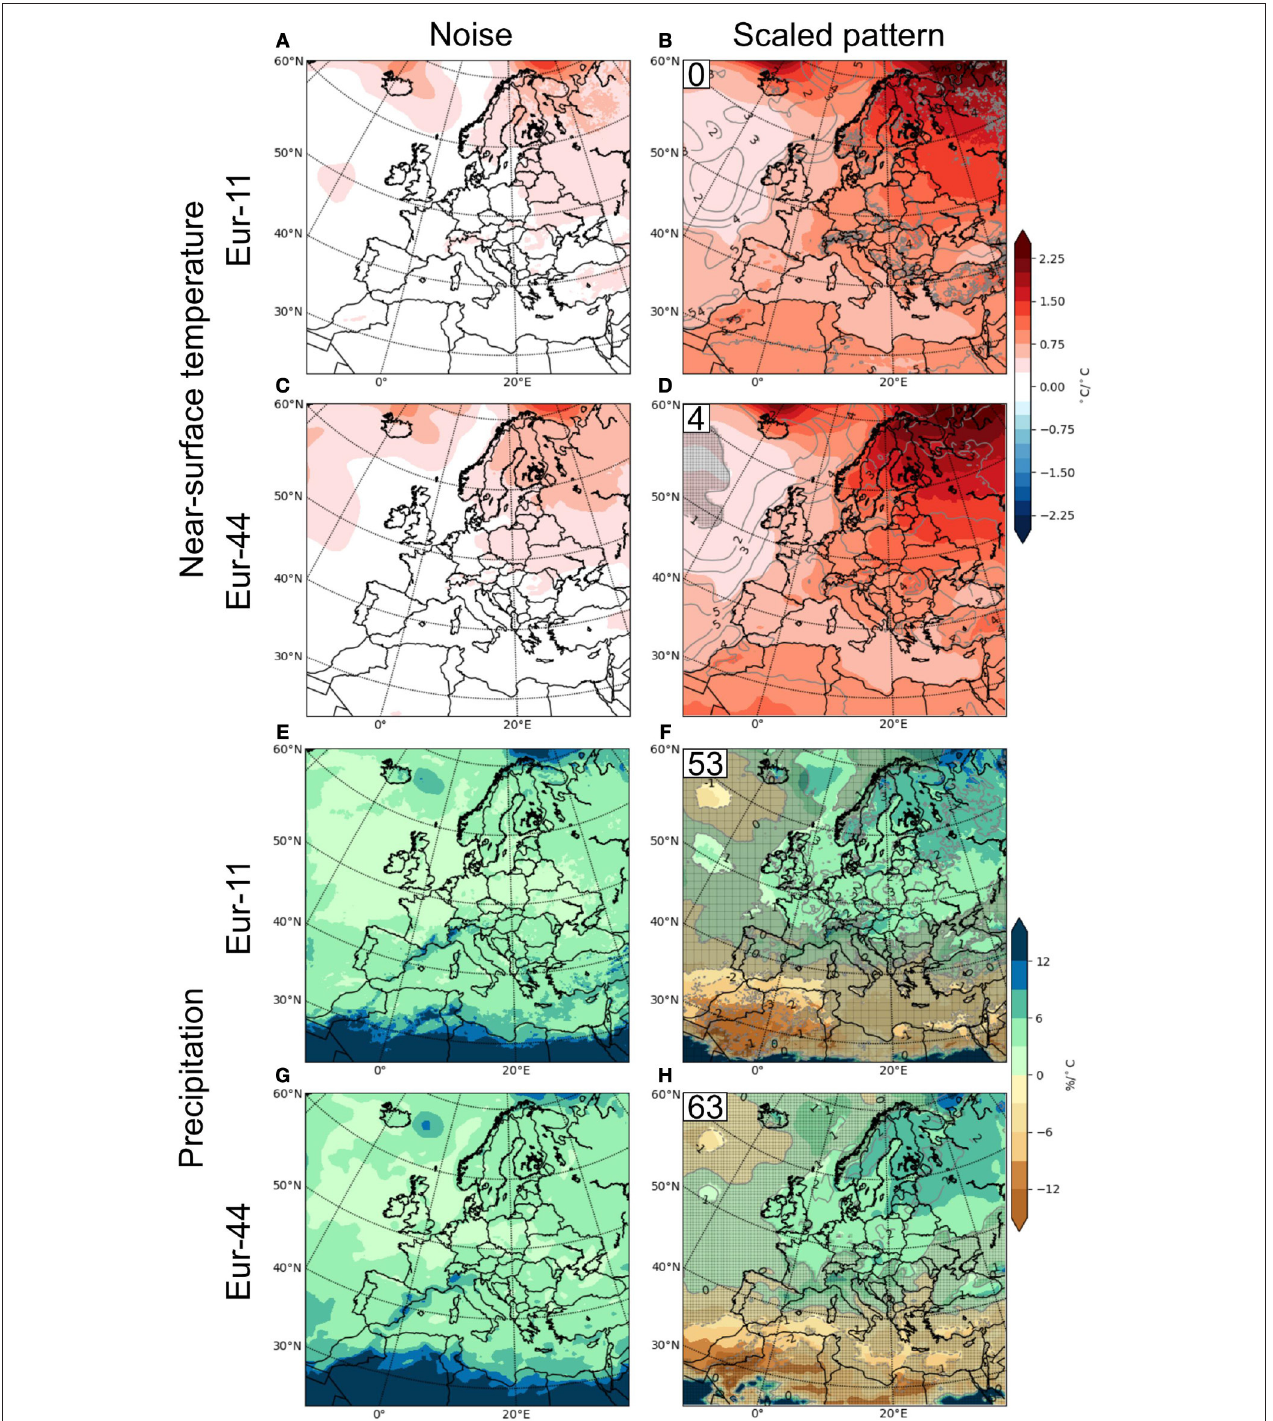
FIGURE 3 | Scaled 2080–2099 DJF patterns for combinations of temperature (A–D) /precipitation (E–H) and EUR-11 (A,B,E,F) /EUR-44 (C,D,G,H) . The left column shows the inter-member noise and the right column shows the 2080–2099 scaled patterns. The contour lines shown in the right column show the S/N ratio and the gray shading depicts areas of S/N < 1. The numbers in the upper left corner of the right column shows the percentage of grid points where S/N < 1. Note that both columns have the same unit.